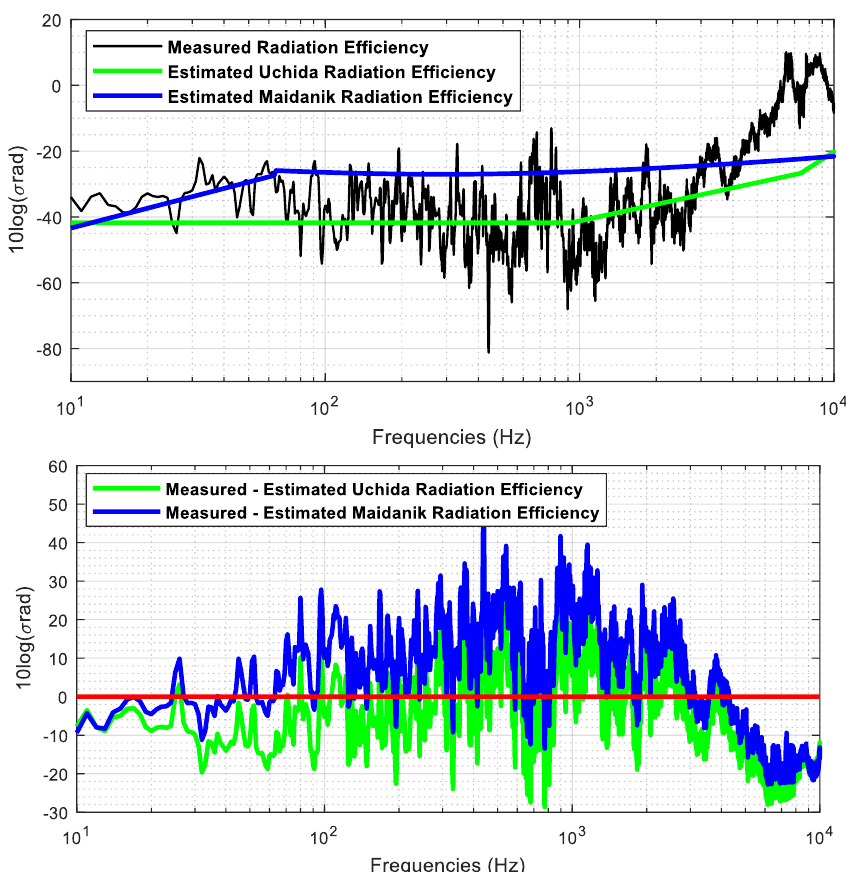
Figure 12. Measured and estimated radiation efficiency in narrowband domain ( top ) and difference between the estimated radiation efficiency using Uchida and Maidanik equations and the computed radiation efficiency from the measurements ( bottom ).